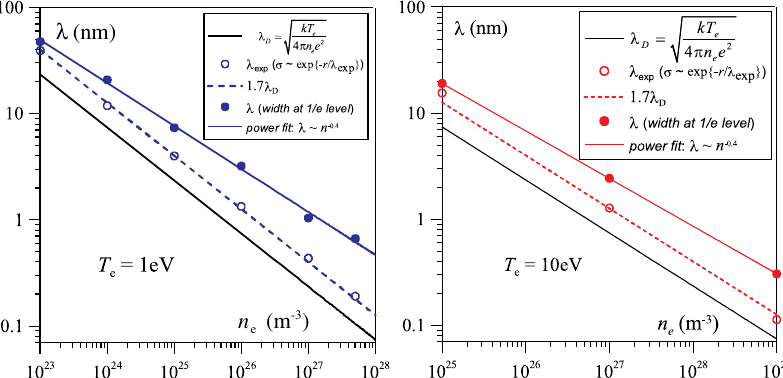
FIG. 8. The Debye length (lower solid line) and the sheath lengths obtained from MD simulations depending on the electron number density. The dashed line is related to the exponential fit (see Fig. 7); the higher solid line represents the width (cid:1) given by the relation (cid:4) ð (cid:1) Þ ¼ (cid:4) ð 0 Þ =e where (cid:4) ð z Þ is the plasma charge profile (Fig. 7). Left figure: T ¼ 1 eV ; right figure: T ¼ 10 eV .